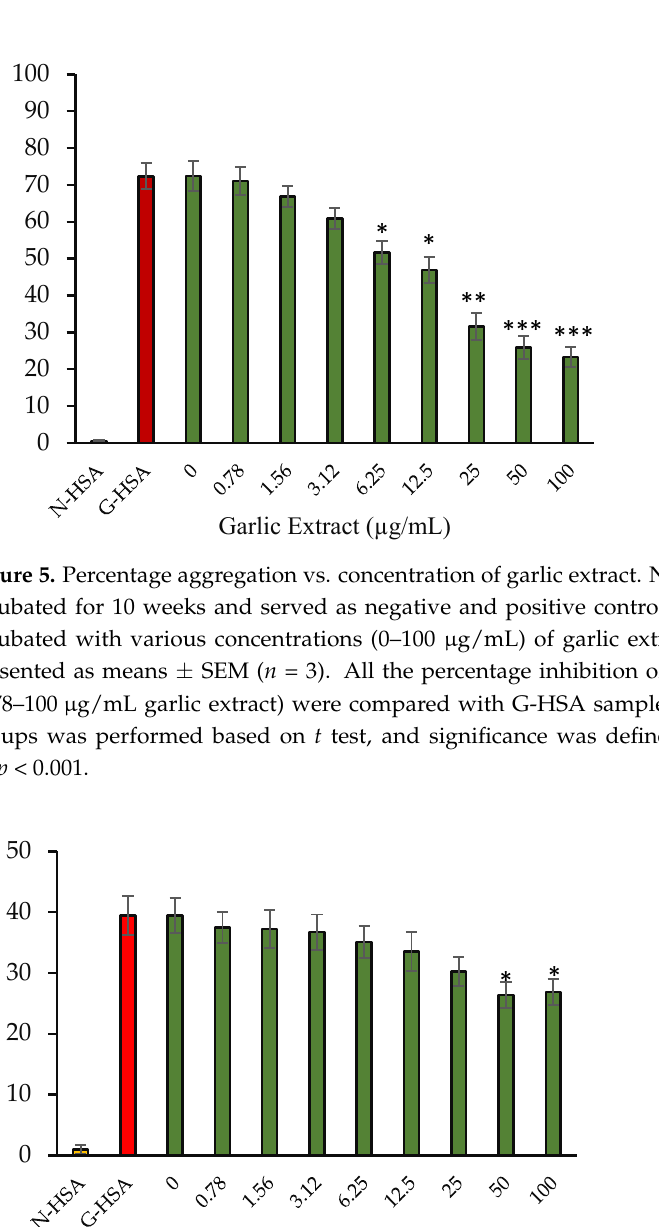
Figure 6. Percentage amyloid structure vs. concentration of garlic extract. Native HSA and G-HSA were incubated for 10 weeks as negative and positive controls, respectively. G-HSA was incubated with various concentrations (0–100 µg/mL) of garlic extract (green). The results are presented as means ± SEM ( n = 3). All the percentage amyloid structure inhibition results (0.78–100 µg/mL garlic extract) were compared with G-HSA sample. Comparison between two groups was performed based on t test, and significance was defined as * p < 0.05 .